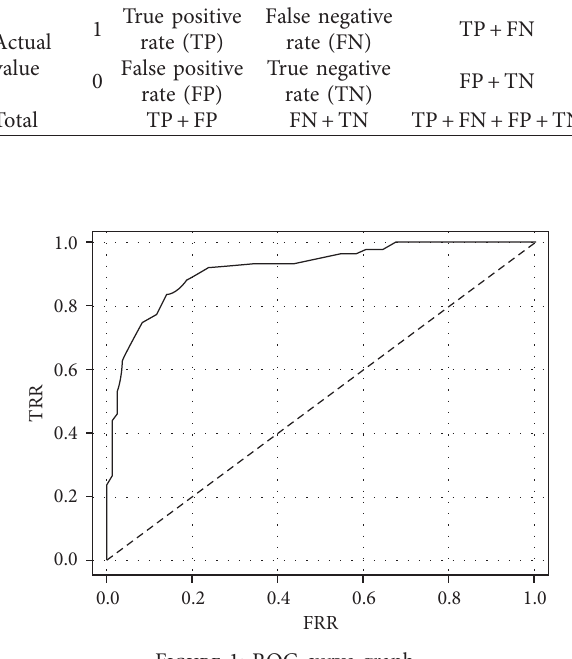
Figure 1: ROC curve graph.